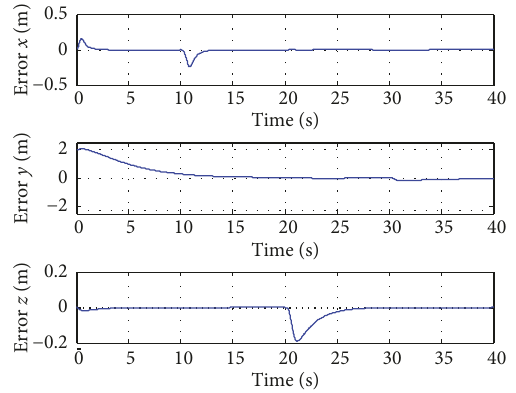
Figure 13: The curve of tracking